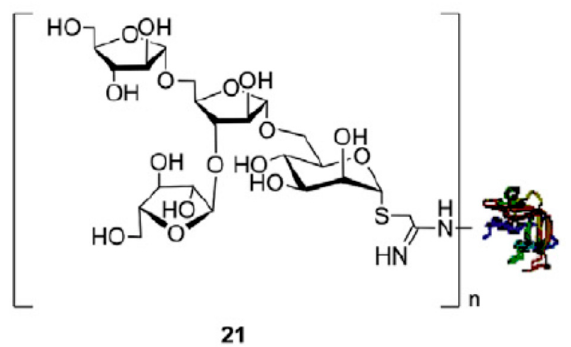
Figure 2. Glycoconjugate of ManAra3-rHSA. Reprinted from Li, Z.; Bavaro, T.; Tengattini, S.; Ber- nardini, R.; Mattei, M.; Annunziata, F.; Cole, R.B.; Zheng, C.; Sollogoub, M.; Tamborini, L., et al. Chemoenzymatic synthesis of arabinomannan (am) glycoconjugates as potential vaccines for tuber- culosis. Eur J Med Chem 2020, 204, 11257 with permission from Elsevier